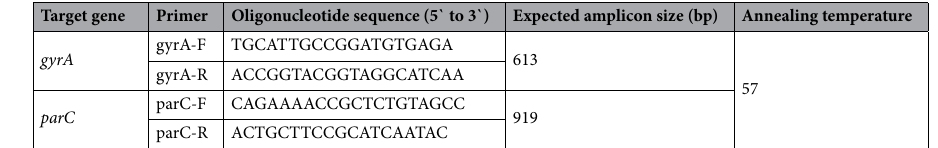
Table 1. Oligonucleotides used to amplify and for sequencing analysis of fluoroquinolone-resistance determining